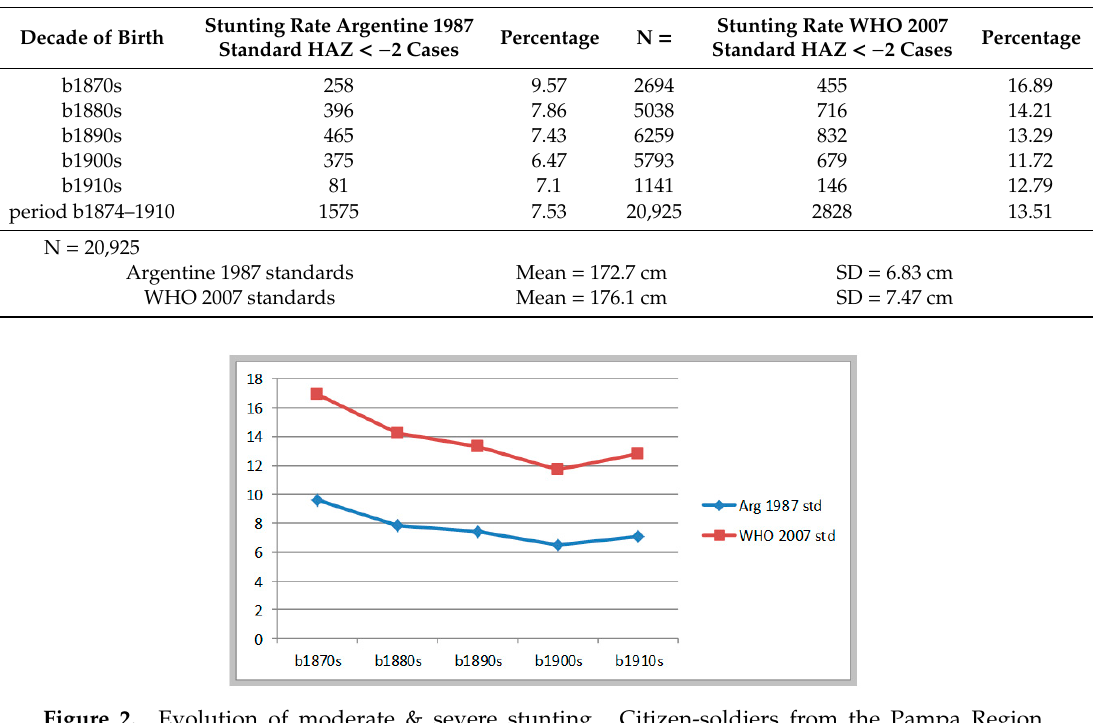
Figure 2. Evolution of moderate & severe stunting. Citizen-soldiers from the Pampa Region b.1874-